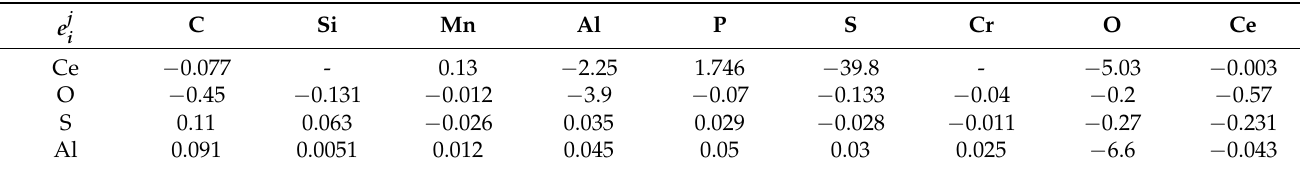
of various elements in tested steel at 1873 K. i